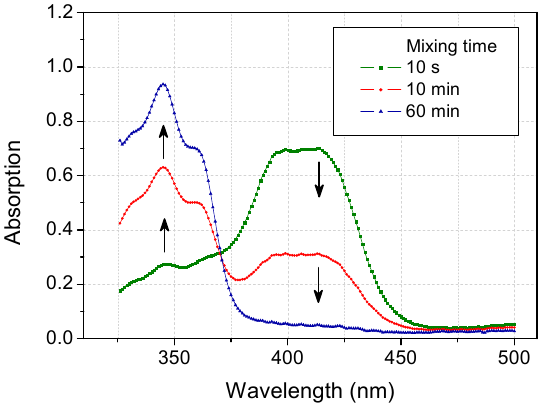
Figure 1. Time-dependent spectra of 2,2 ′ -azino-bis(3-ethylbenzothiazoline-6-sulfonic acid) (ABTS) radicals in 80% ( v / v ) Aq/Ac.